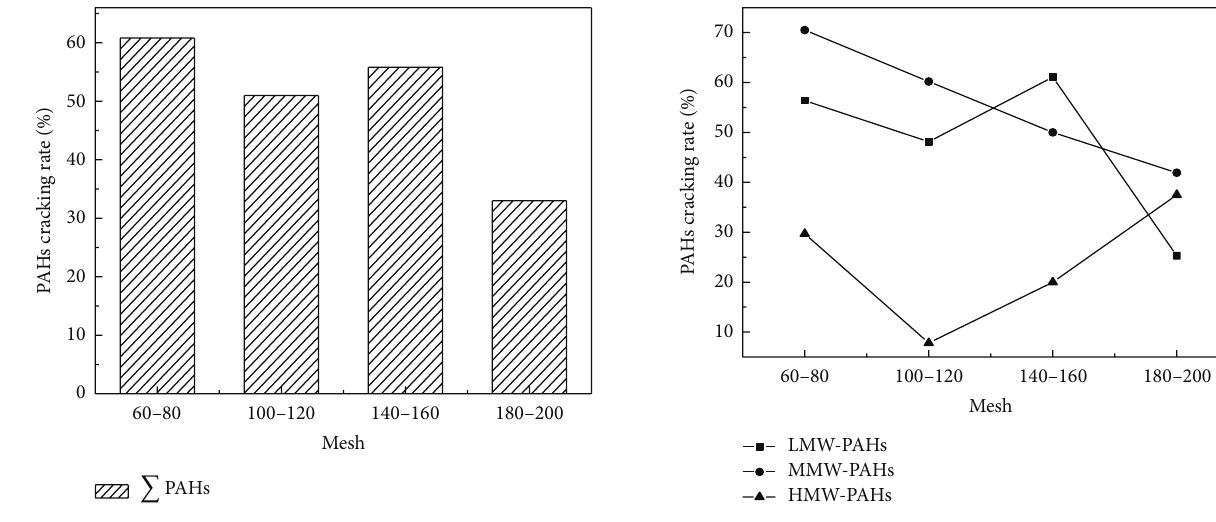
Figure 7: Relationship between the rings cracking rate distribution of PAHs and particle size of Fe 2 O 3 .